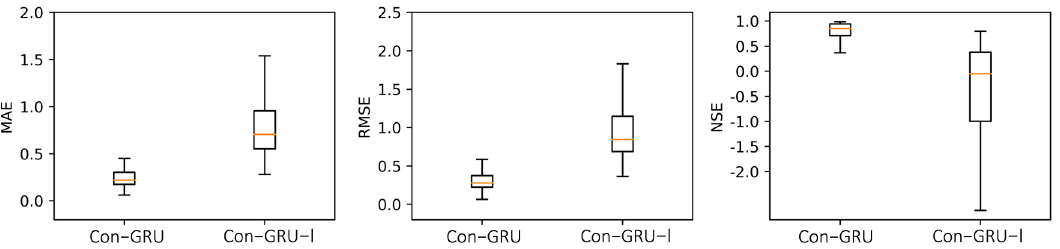
Figure 11. Comparison of the Con-GRU model and Con-GRU-I model on the validation dataset for 3 h data repair results.